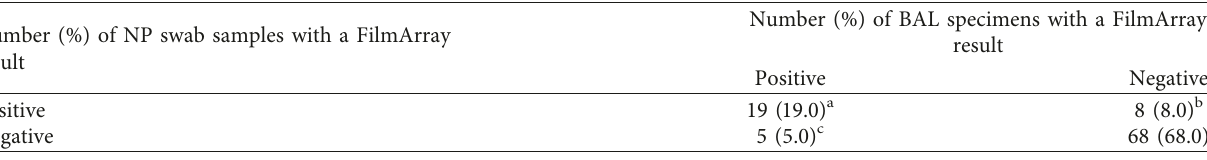
Table 3: Comparison of FilmArray Respiratory Panel using paired nasopharyngeal swab and BAL samples collected from immuno- compromised hosts ( n � 100).